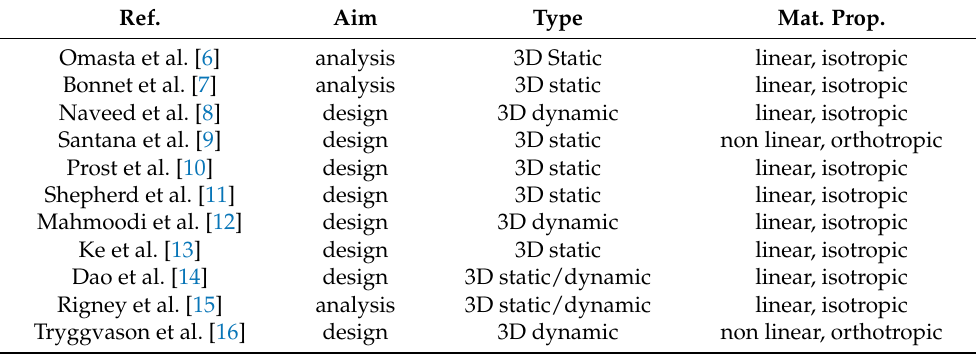
Table 2. Aim and type of simulations and material properties used in previous works where finite element analysis is applied to study foot